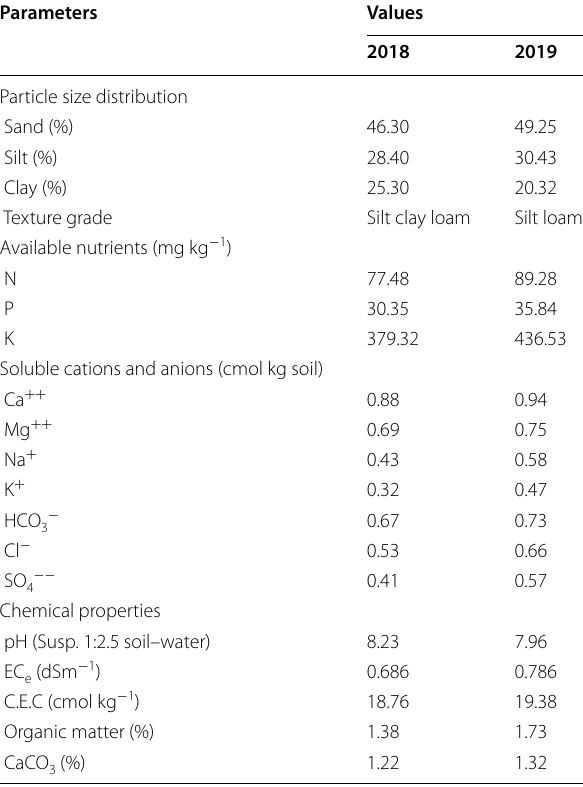
Table 1 Some physical and chemical characteristics of soil experimental